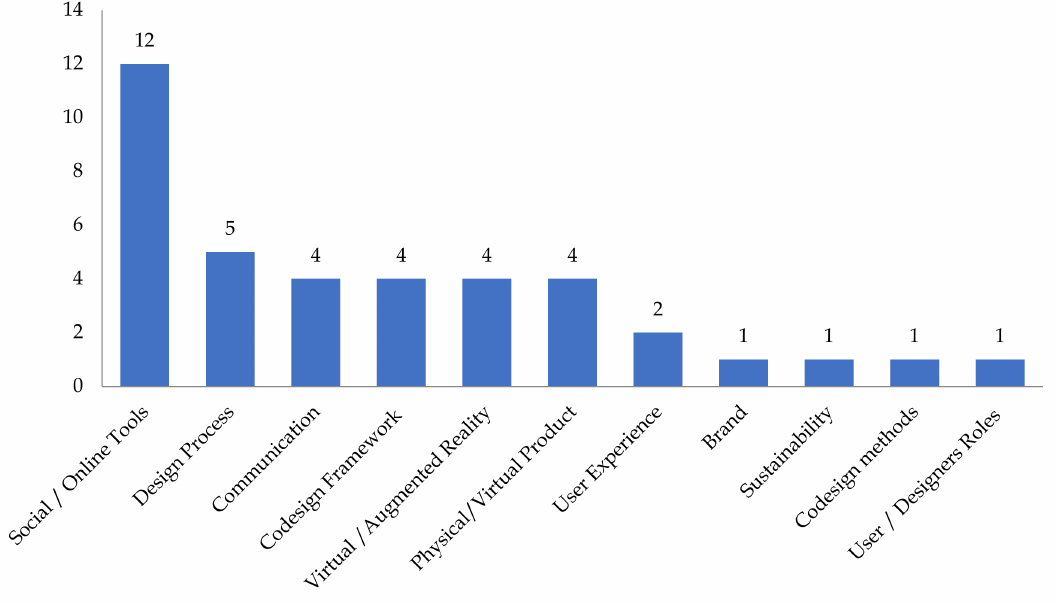
Figure 8. Web-based product co-design research topics